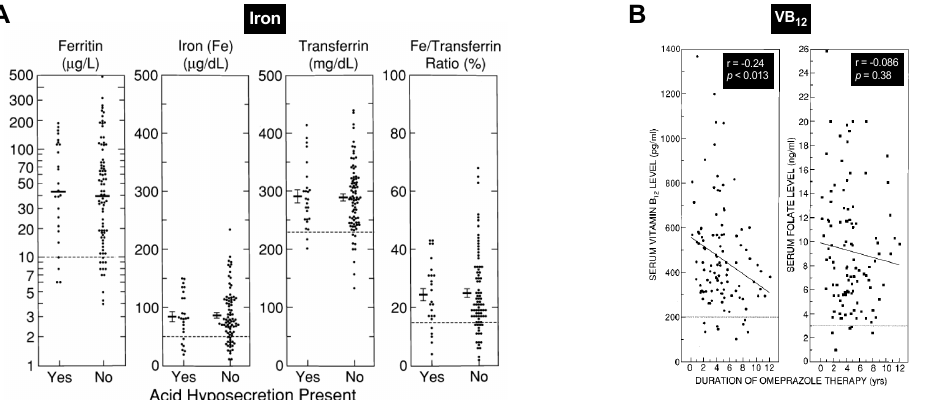
Figure 4. E ff ect of prolonged PPI treatment in ZES patients on body iron stores / levels ( A ) or serum vitamin B 12 and folate levels in two NIH ( B ). In ( A ), data from 109 ZES patients treated with antisecretory drugs for a mean of 10.2 years are shown (81% PPIs for 6 years, 8% histamine H 2 receptor antagonist, 10% cured, off all drugs). Results are shown for patients with or without advanced basal acid hyposecretion on the antisecretory drug. Normal values are shown by the dotted lines and means ± SEM are also shown for each group. ( B ) shows serum vitamin B 12 and folate levels in 108 ZES patients correlated with time of omeprazole treatment. The serum vitamin B 12 levels inversely correlated with the time of omeprazole treatment, whereas there was no effect on the serum folate levels. Figures are drawn from data in [27,253]. These data showed that prolonged chronic treatment in ZES patients did not affect serum iron levels or iron body stores, however there was a significant decrease in serum vitamin B 12 levels correlating with PPI treatment duration, but not serum folate levels.